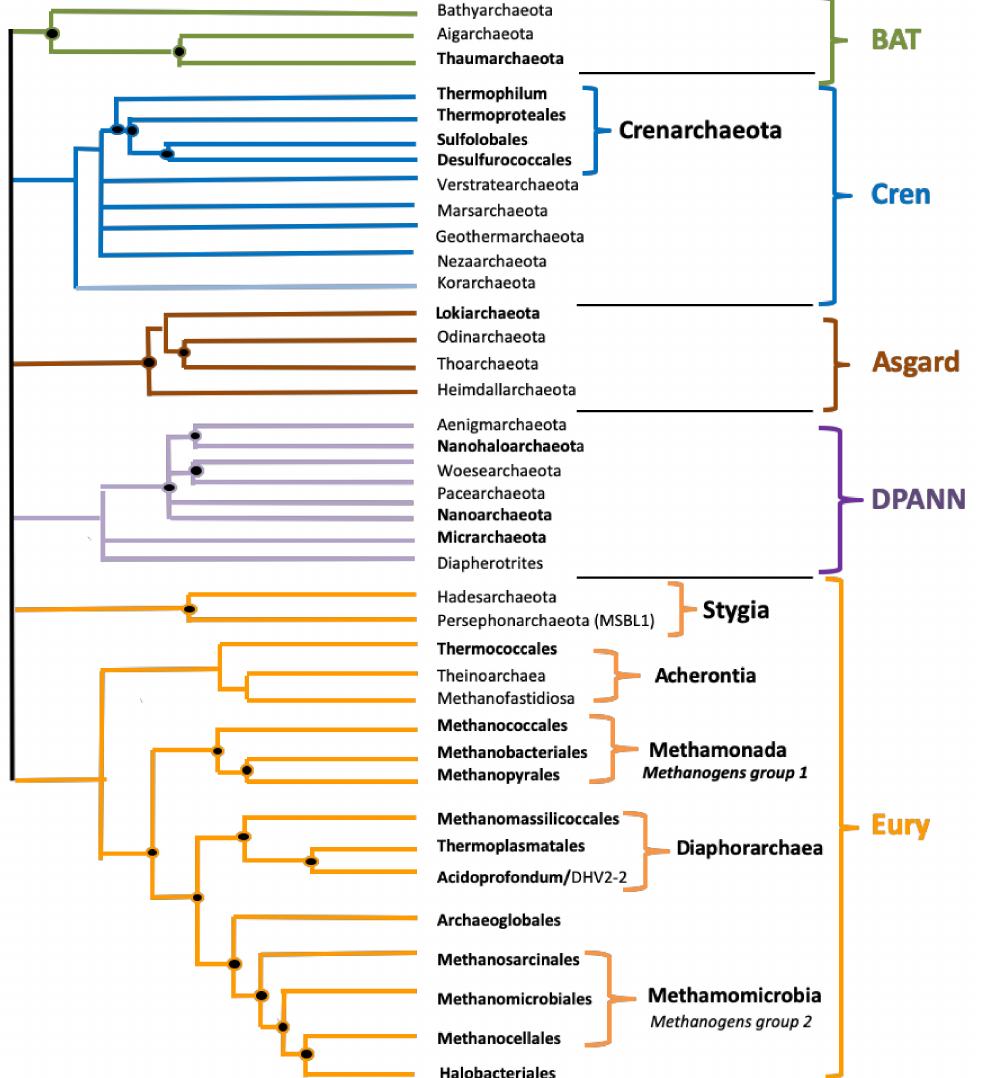
Figure 1. A schematic phylogenic tree for Archaea. This unrooted evolutionary tree of Archaea is